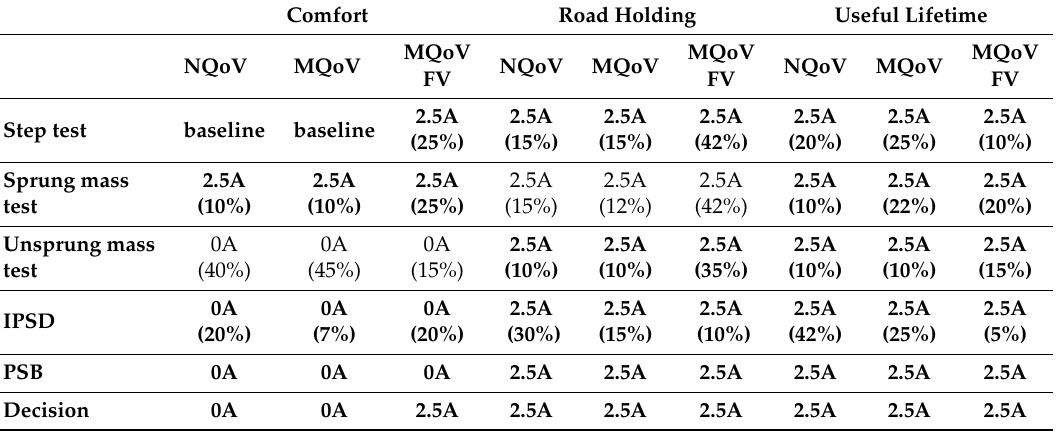
Table 12. QoV Results in open loop.